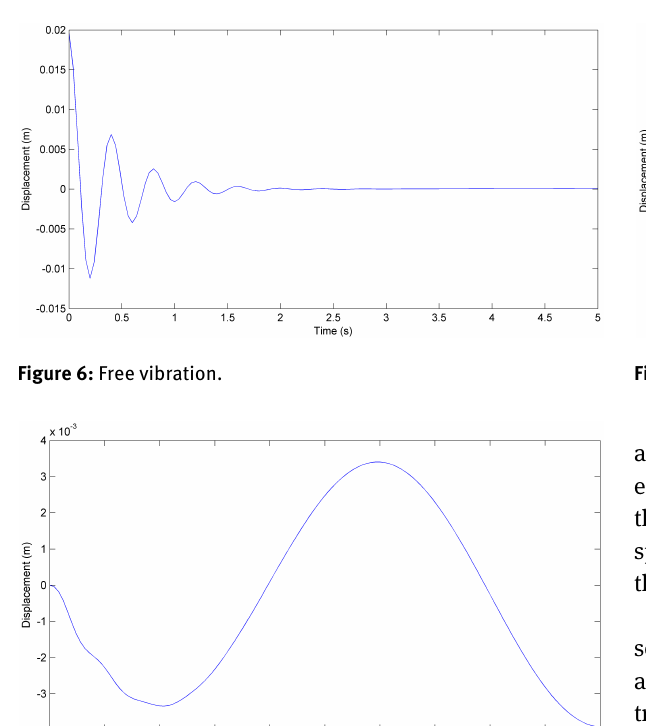
dynamic responses in both frequency and time domains. Dynamic responses in frequency, as shown in Figures 4